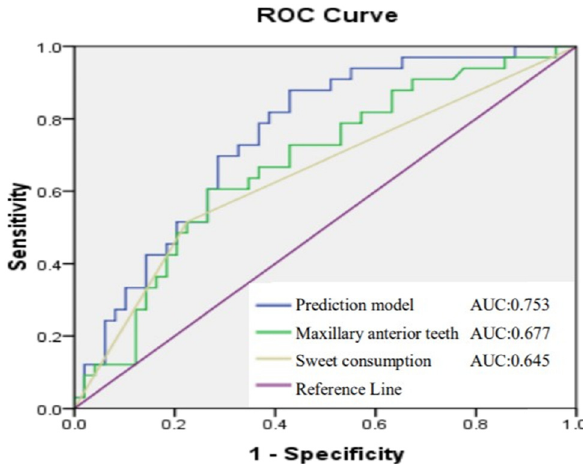
Figure 3: ROC curve of maxillary anterior teeth ( P = 0.006 ) and liking the sweet food ( P = 0.007 )